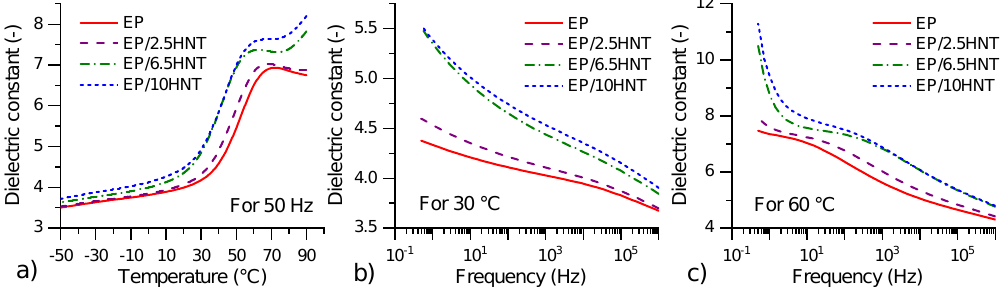
Figure 6. Dielectric constant characteristics: ( a ) Temperature dependencies at 50 Hz, ( b ) frequency dependencies at 30 ◦ C, and ( c ) frequency dependencies at 60 ◦ C for all tested materials.